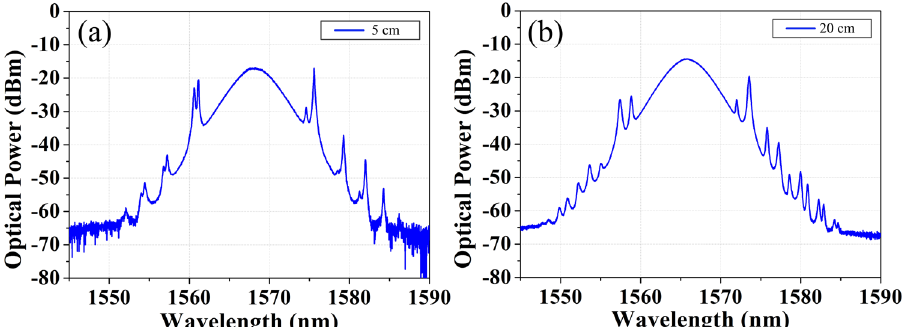
Figure 7. Optical spectra of the GVLVSs with ( a ) 5 cm and ( b ) 20 cm